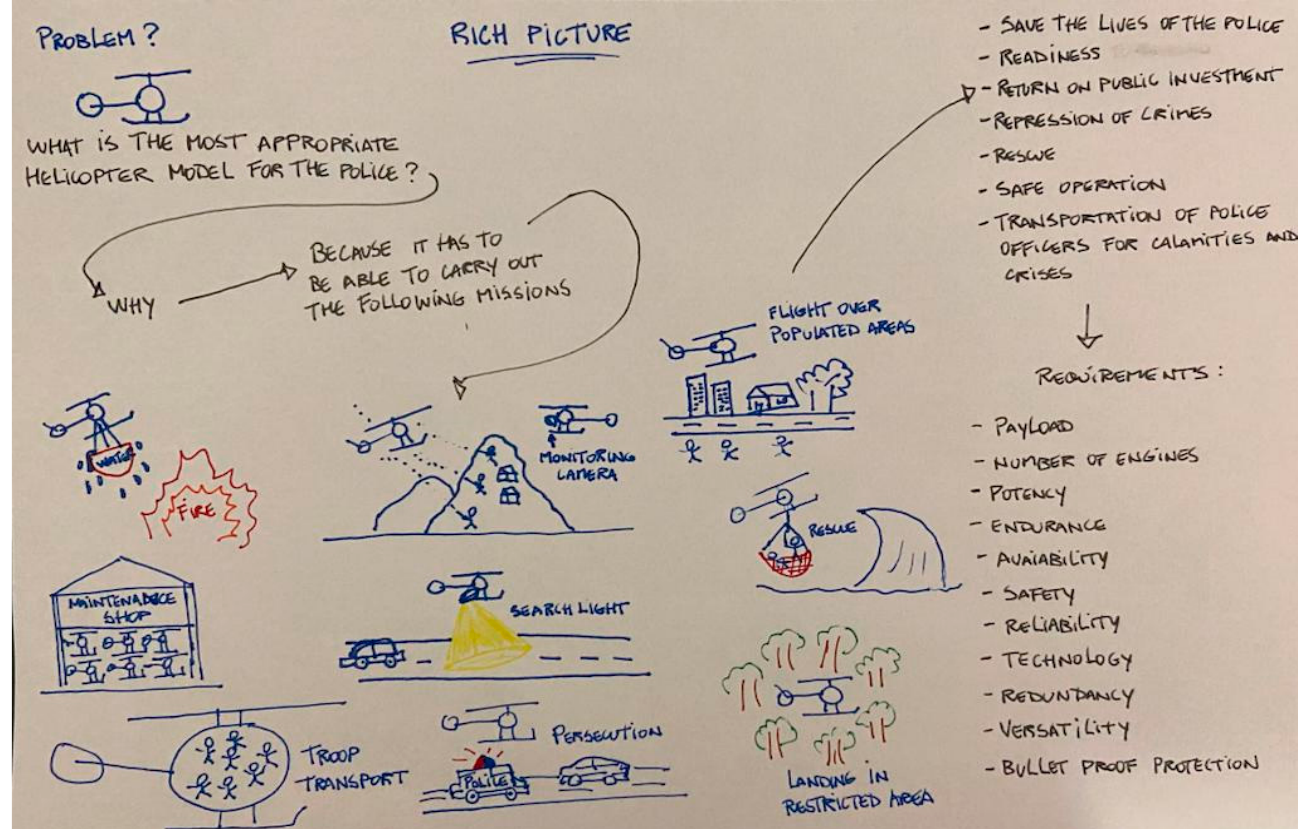
Figure 1. Rich picture illustrating the various applications of helicopters to police activity in a significant metropolis. Source: The authors. Note: This figure has been produced by Soft System Methodology (SSM) [25].